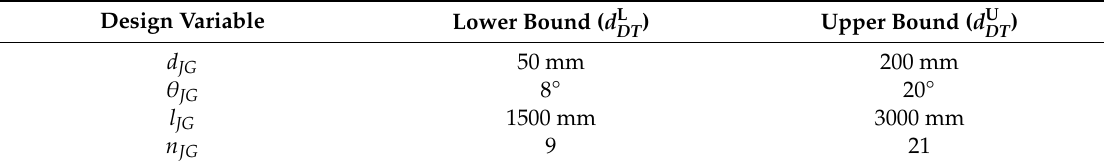
Table 6. Bounds for design variables of draft tube shape.